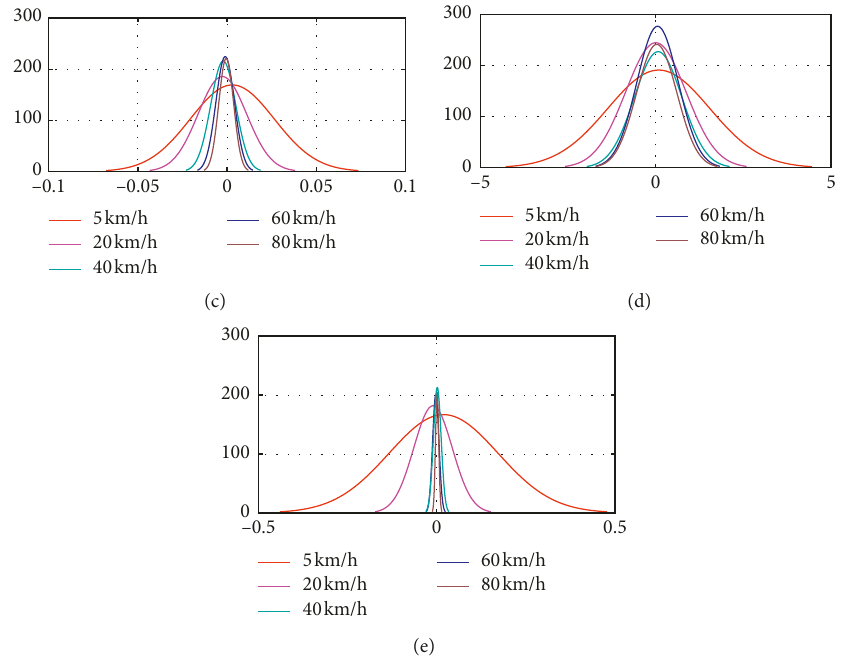
Figure 18: Distribution of the state estimation errors. (a) z